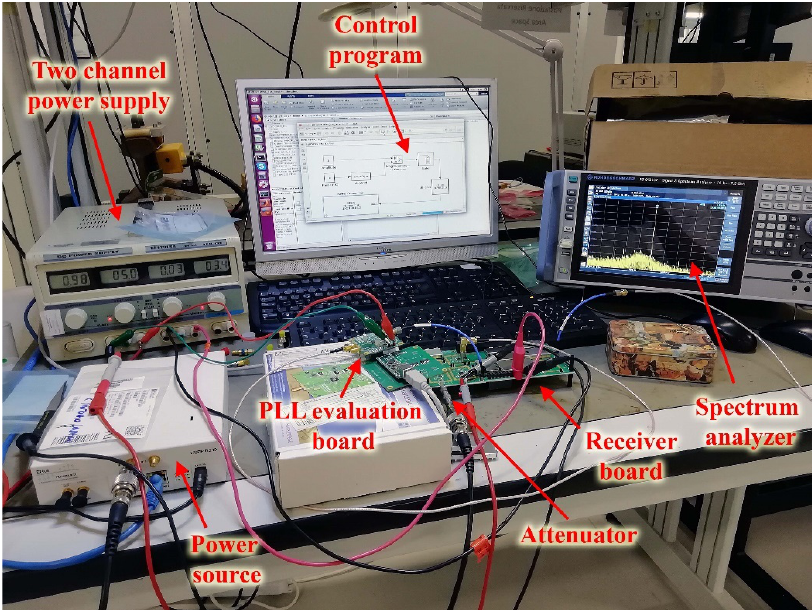
Figure 9. Photograph of the test setup really implemented for the board-level tests executed for the RF receiver.